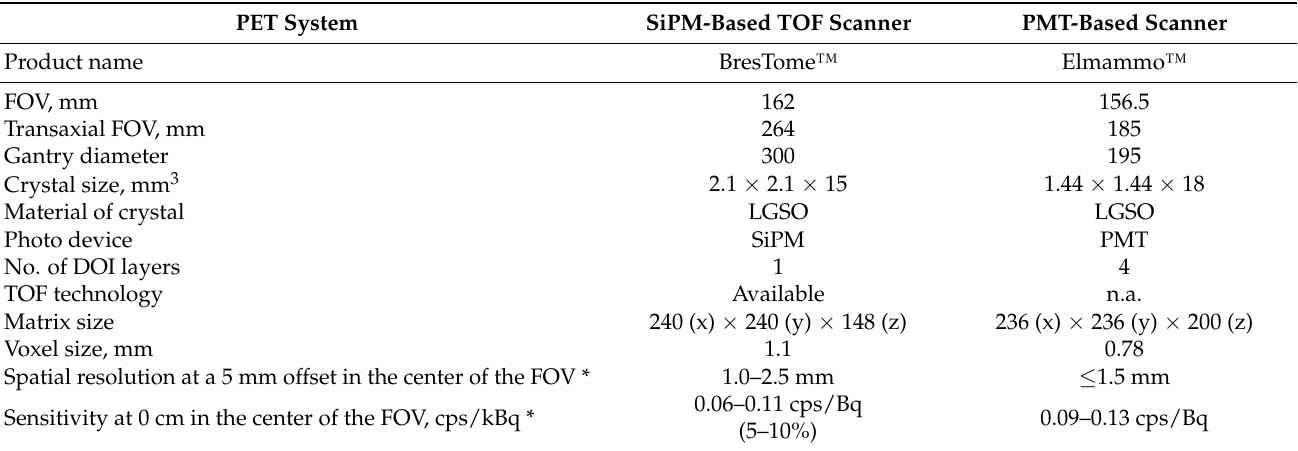
Table 1. Scanner characteristics of the silicon photomultiplier tube (SiPM)-based time-of-flight (TOF) scanner and the photomultiplier tube (PMT)-based scanner † .